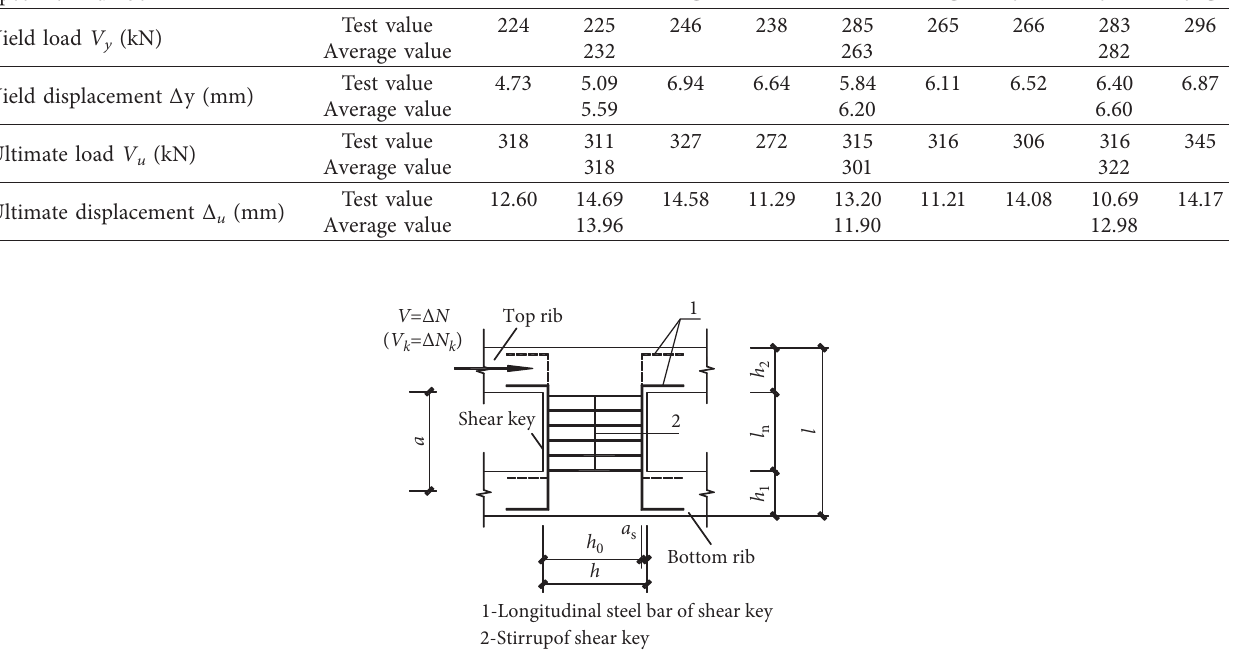
Figure 24: Schematic diagram of shear bearing capacity computation of key